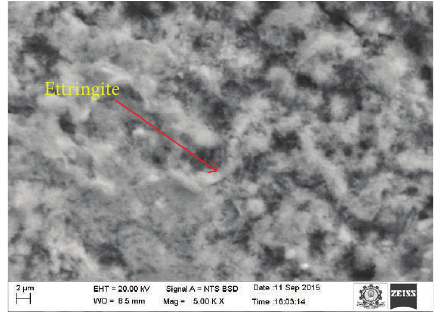
Figure 3: SEM image for SFCS5 specimen.